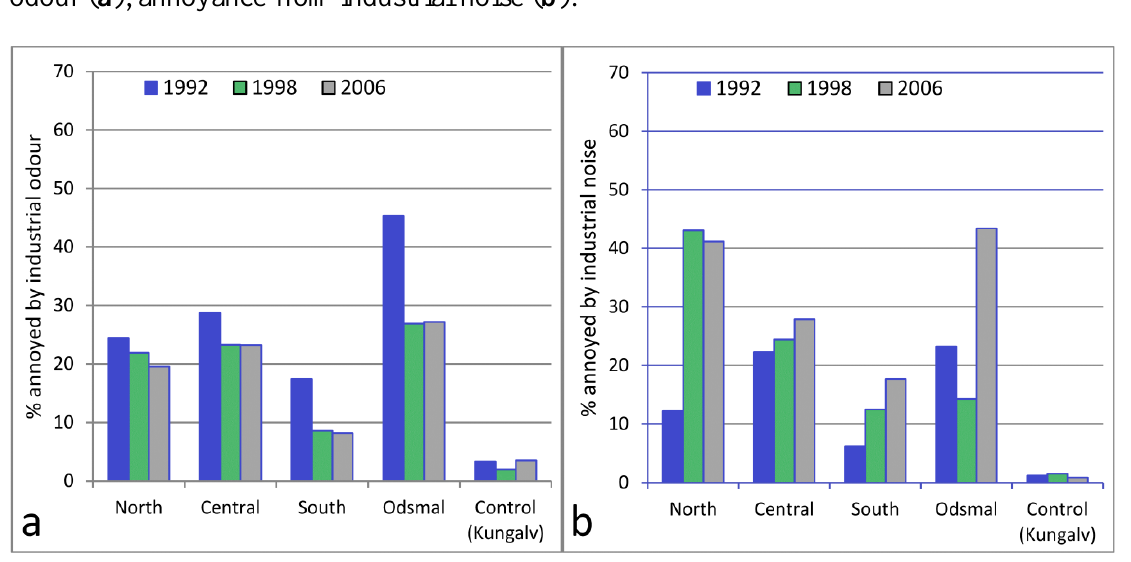
Figure 4. Prevalence of annoyance for each exposed area (North, Central, and South Stenungsund, and Odsmal) and the control area (Kungalv). Annoyance from industrial odour ( a ); annoyance from industrial noise ( b